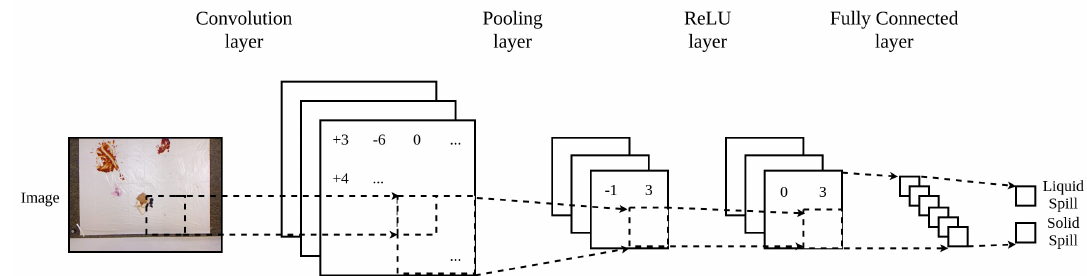
Figure 1. Structure of